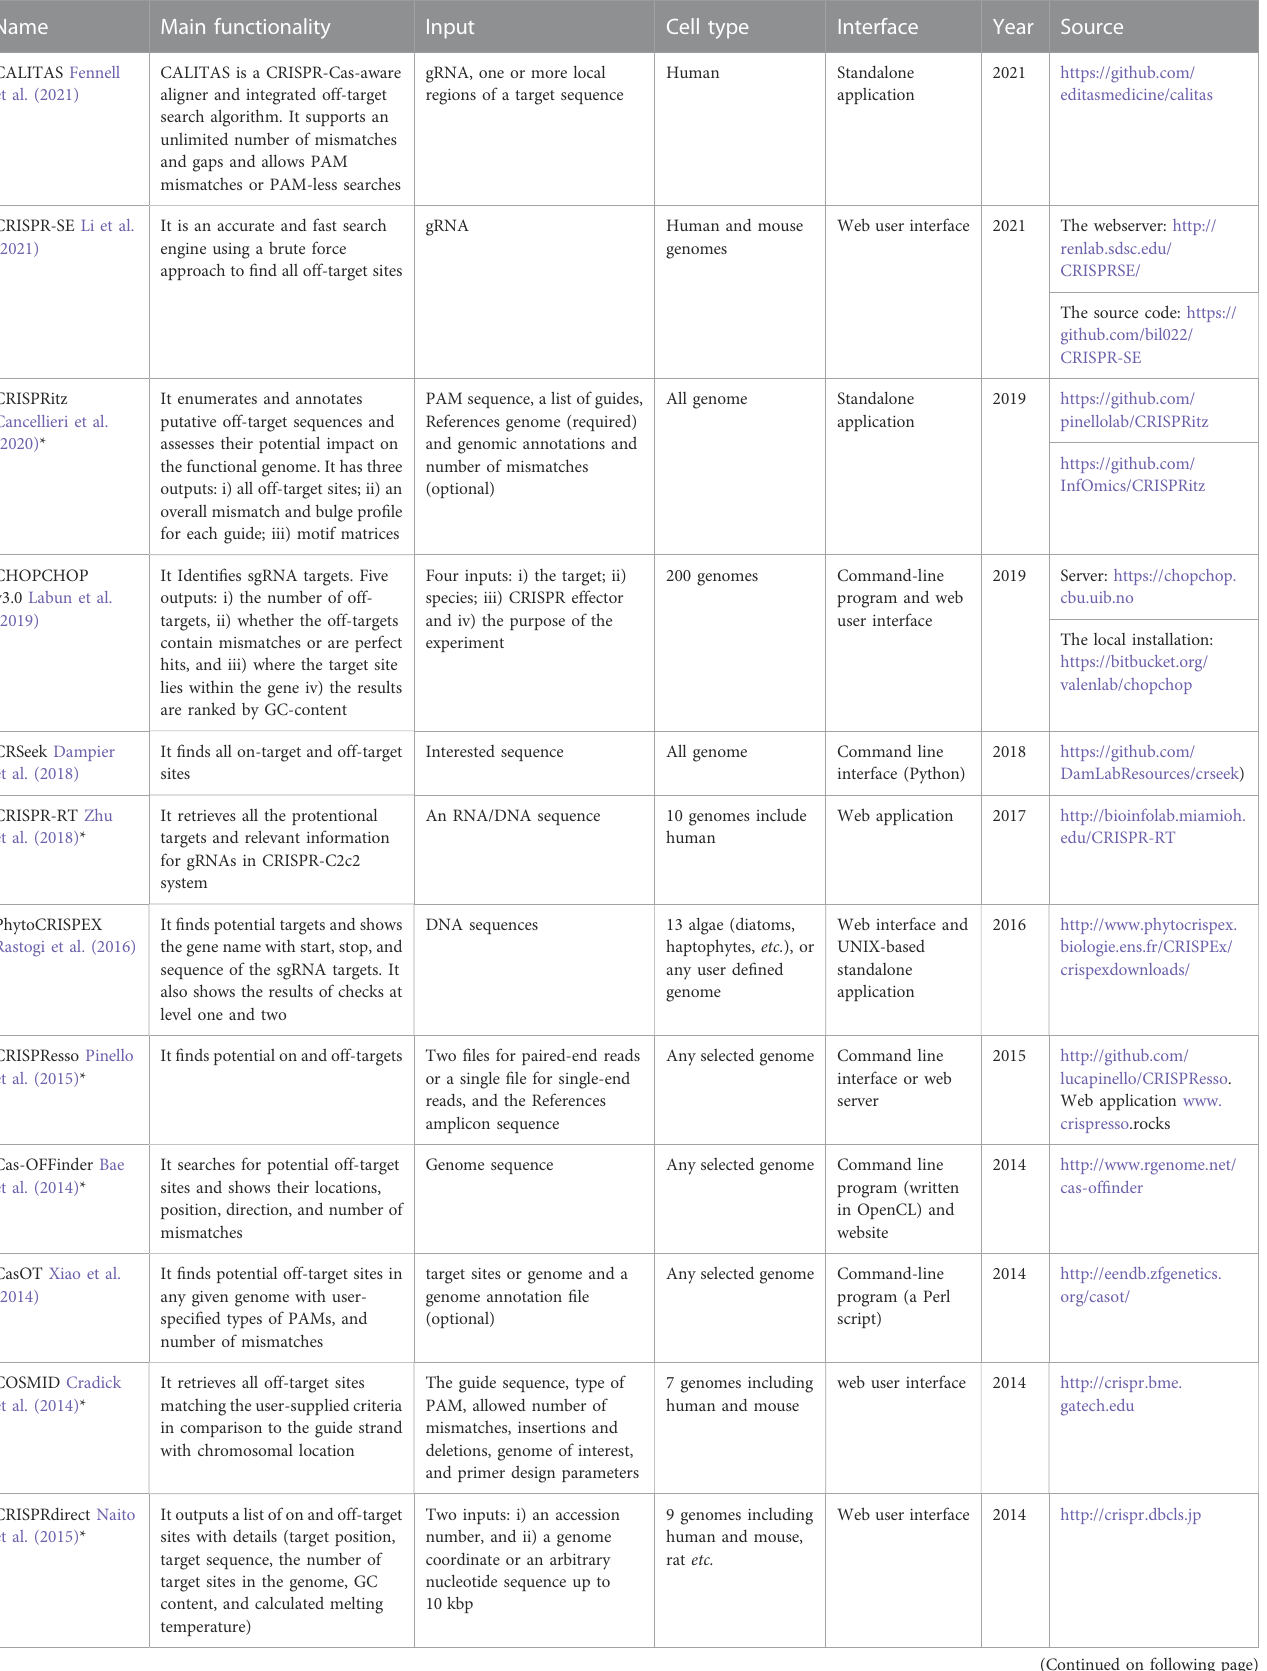
TABLE 2 Tools and software packages related to fi nding off-target